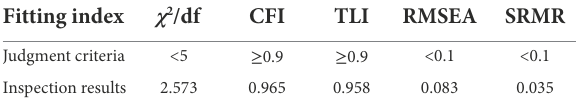
TABLE 4 Fitting index of the